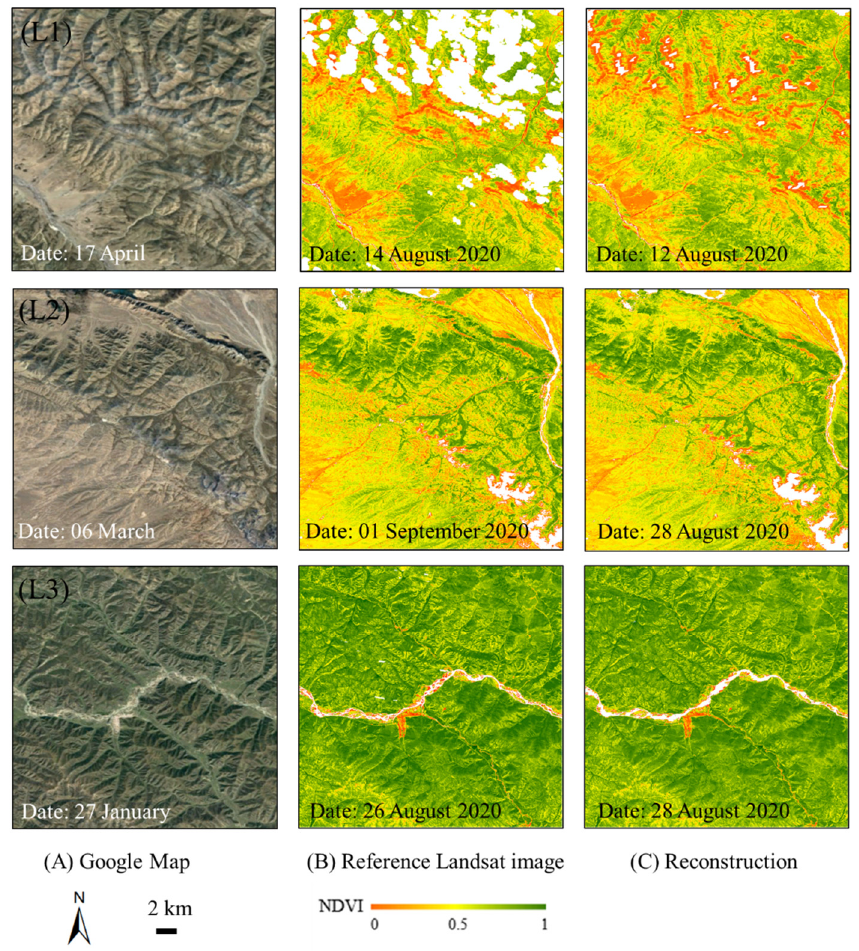
Figure 6. Comparisons between the reference Landsat NDVI images ( B ) and the reconstructed Landsat NDVI images ( C ) in the three subregions. The landscapes of the three subregions from Google Maps are shown ( A ). Note: the reference Landsat NDVI images, including those with cloud- free pixels, were not used in the reconstruction